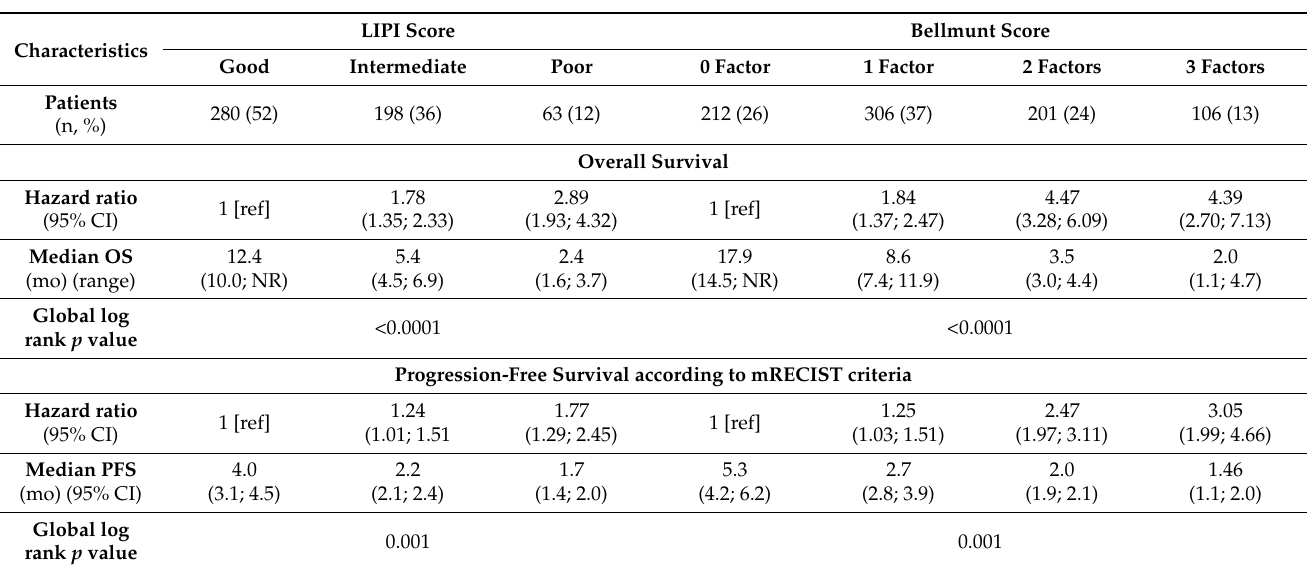
Figure 3. OS and PFS according to LIPI group in the Chemo cohort. Overall survival (OS) and progression-free survival (PFS) according to the LIPI score. ( A ) OS; ( B ) PFS. Table 3. Comparison of outcomes with LIPI and Bellmunt scores in the SAUL cohort. HR: hazard ratio; CI: confidence interval; LIPI: lung immune prognostic index; NR: not reached; mRECIST: modified response evaluation criteria in solid